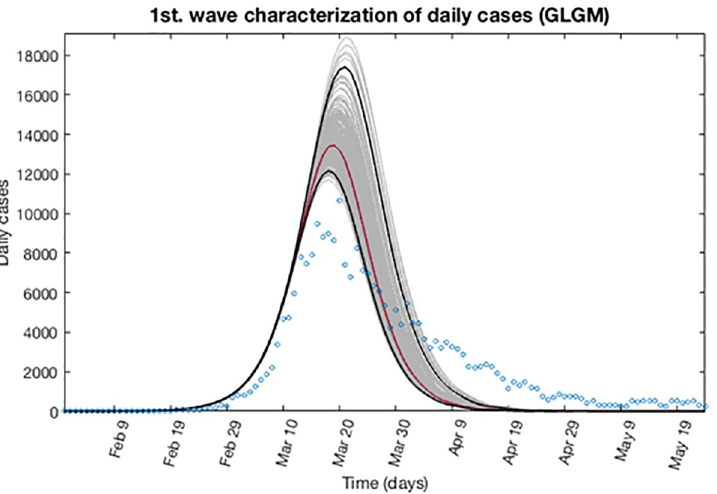
Fig 7. Characterization of the daily epidemic profile for the first wave using GLGM. The blue circles are the cases reported daily; red line corresponds to the best fit of the GLGM to the data. Grey lines correspond to the m bootstrapping realizations of the epidemic curves. Black lines correspond to the 95% CI